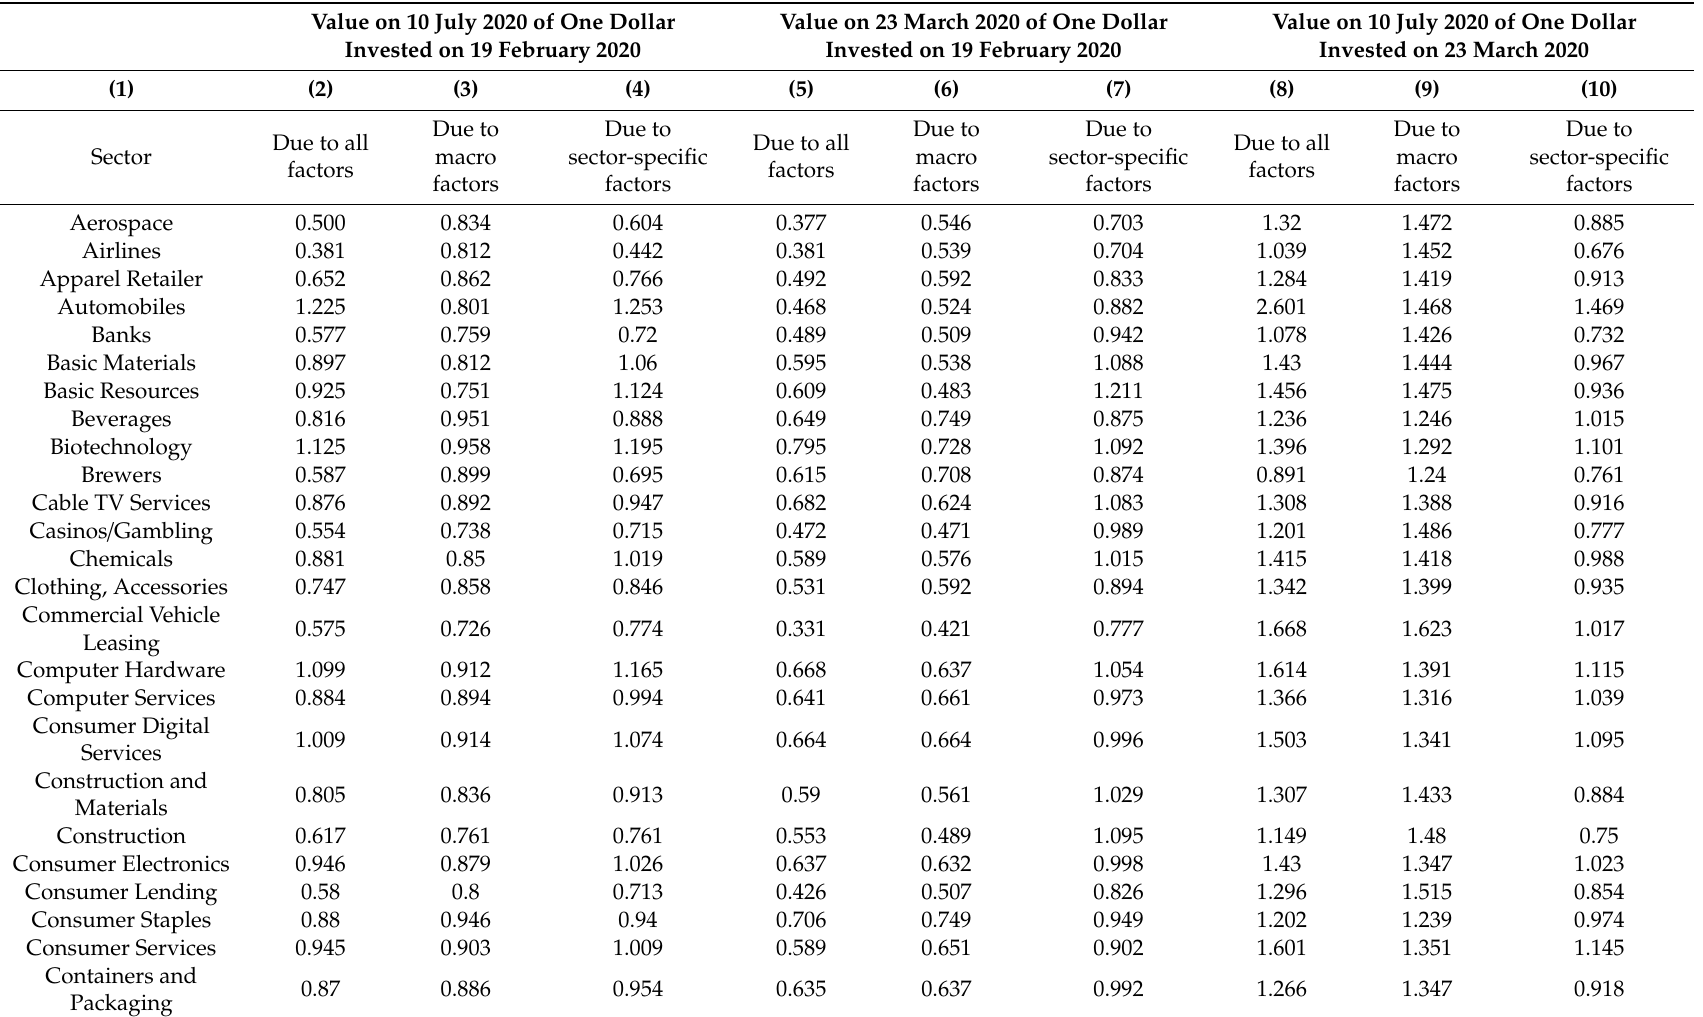
Table 1. Value of one dollar invested across U.S. sectors explained by eight macroeconomic variables and by sector-specific